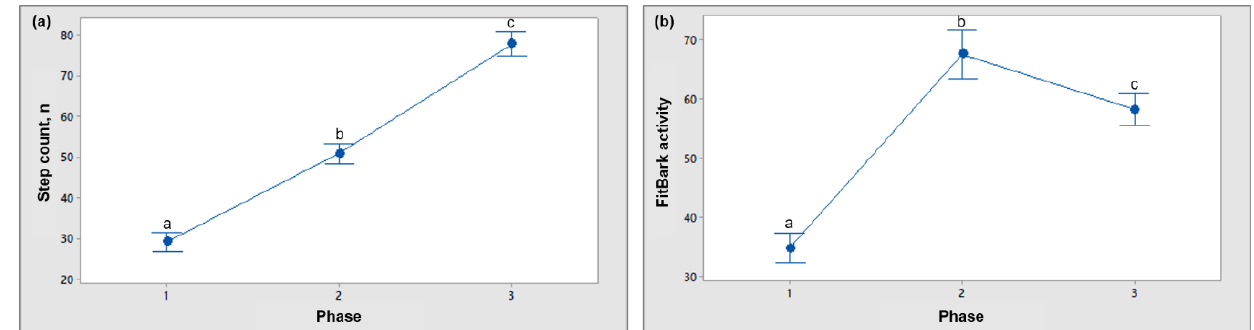
Figure 1. Interval plot showing the 95% confidence interval for the mean of dog step count ( a ) and activity recorded by a FitBark 2 monitor ( b ) across phase 1 (off-leash room explore), 2 (human-dog interaction), and 3 (on-leash walk). Different superscripts indicate significance at p < 0.05.